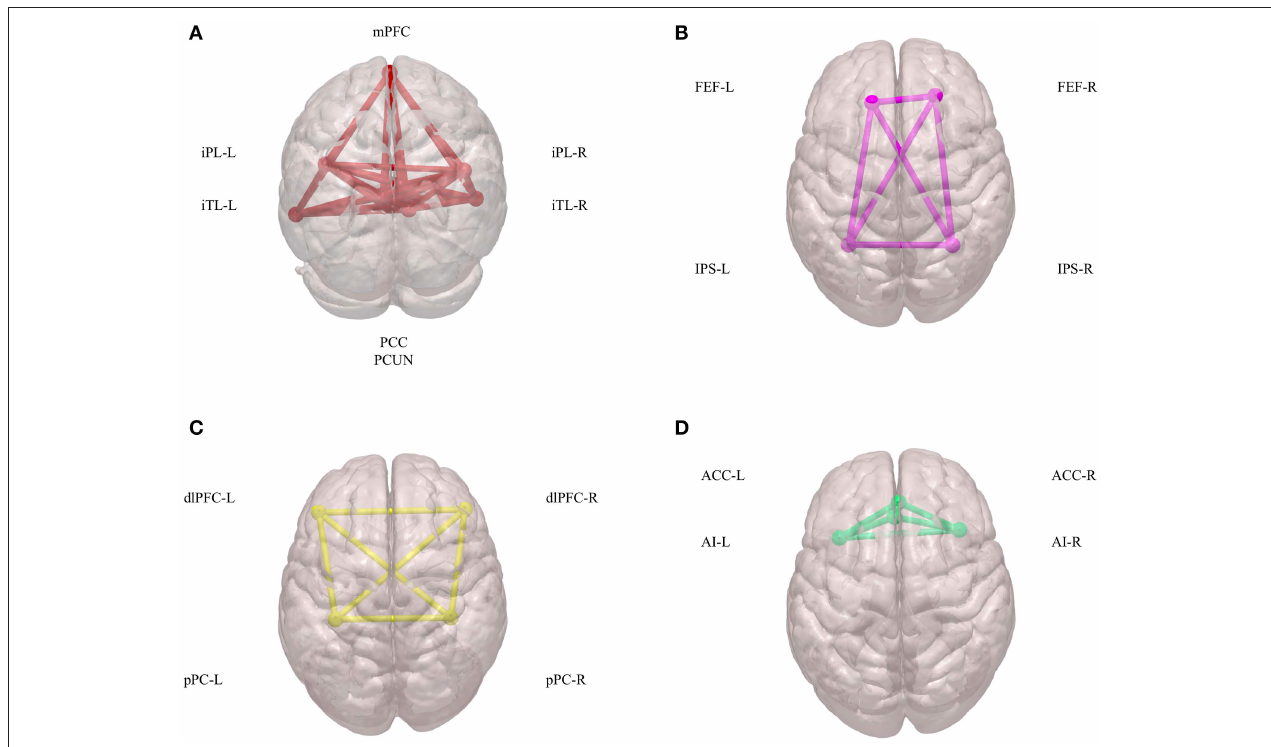
FIGURE 1 | Components of DMN, DAN, CEN, and SN. (A) Spatial components of DMN. (B) Spatial components of DAN. (C) Spatial components of CEN. (D) Spatial components of SN. DMN, default mode network; DAN, dorsal attention network; CEN, central executive network; SN, salience network; mPFC, medial prefrontal cortex; iPL, inferior parietal lobe; iTL, inferior temporal lobes; PCC, posterior cingulate cortex; PCUN, adjacent precuneus; FEF, frontal eye fields; IPS, intraparietal sulcus; dlPFC, dorsal lateral prefrontal cortex; pPC, posterior parietal cortex; ACC, anterior cingulate cortex; AI, anterior